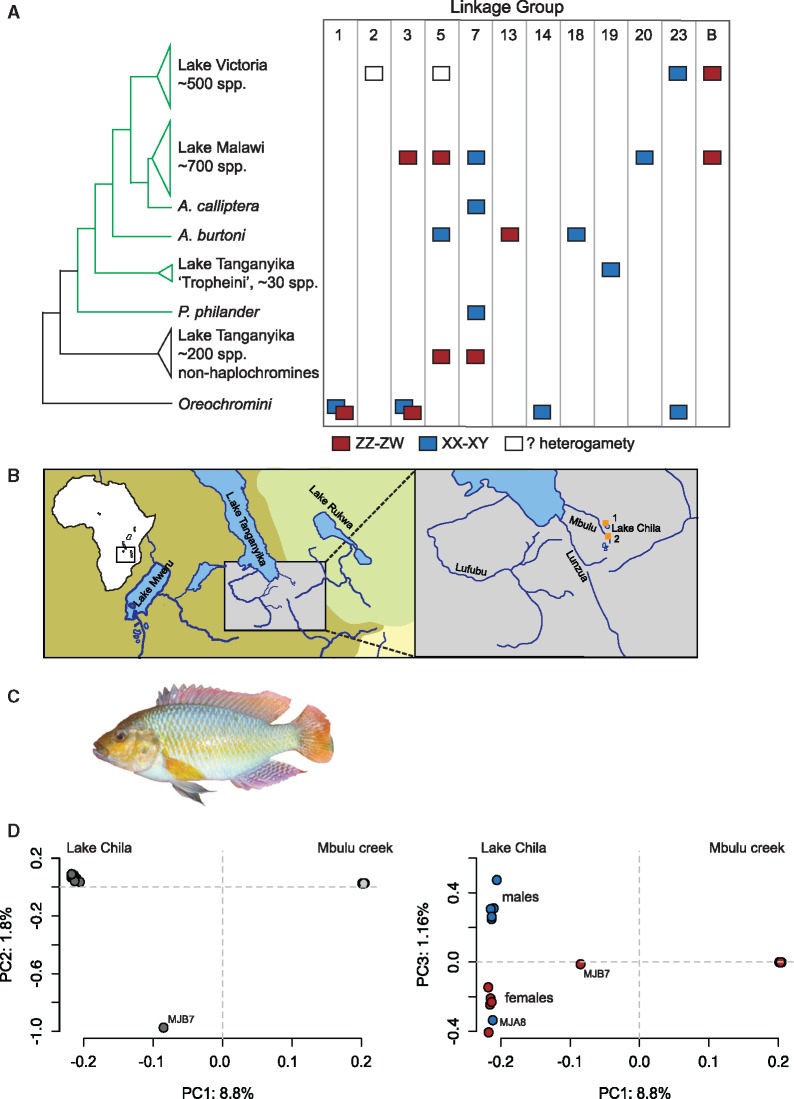
—Phylogenetic relationships and sex determination in East African cichlids. (A) Schematic phylogenetic relationships of East African cichlids. Information on sex determination systems based on Böhne et al. (2016), Cnaani et al. (2008), Feulner et al. (2018), Gammerdinger et al. (2018a, b), Kudo et al. (2015), Parnell and Streelman (2013), Peterson et al. (2017), Roberts et al. (2016), Ser et al. (2010), and Yoshida et al. (2011). Haplochromine lineages are depicted in green. (B) Map of East Africa and a zoom on the sampling locations: 1, Lake Chila and 2, Mbulu creek. (C) Male specimen of Pseudocrenilabrus philander. (D) PCA on genome-wide variant data of all P. philander individuals of this study. PC1 separates the lake individuals from the creek population. PC3 separates males from females. The outlier MJB7 and the potential sex-reversed individual MJA8 are highlighted: dark gray: Lake Chila, light gray: Mbulu creek, red: females, and blue: males.